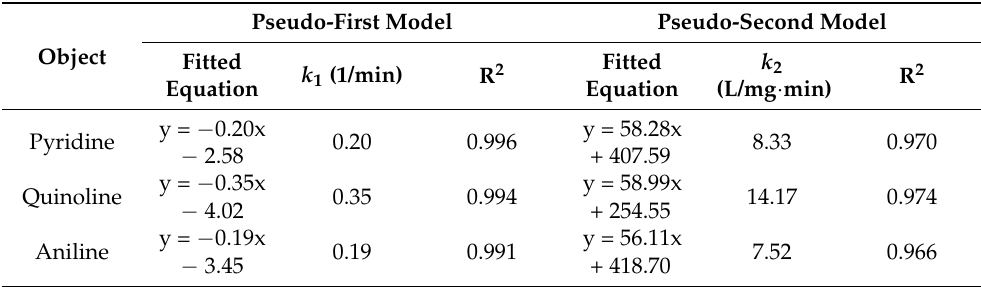
Table 3. The fitting results of pseudo-first order and pseudo-second order models for three